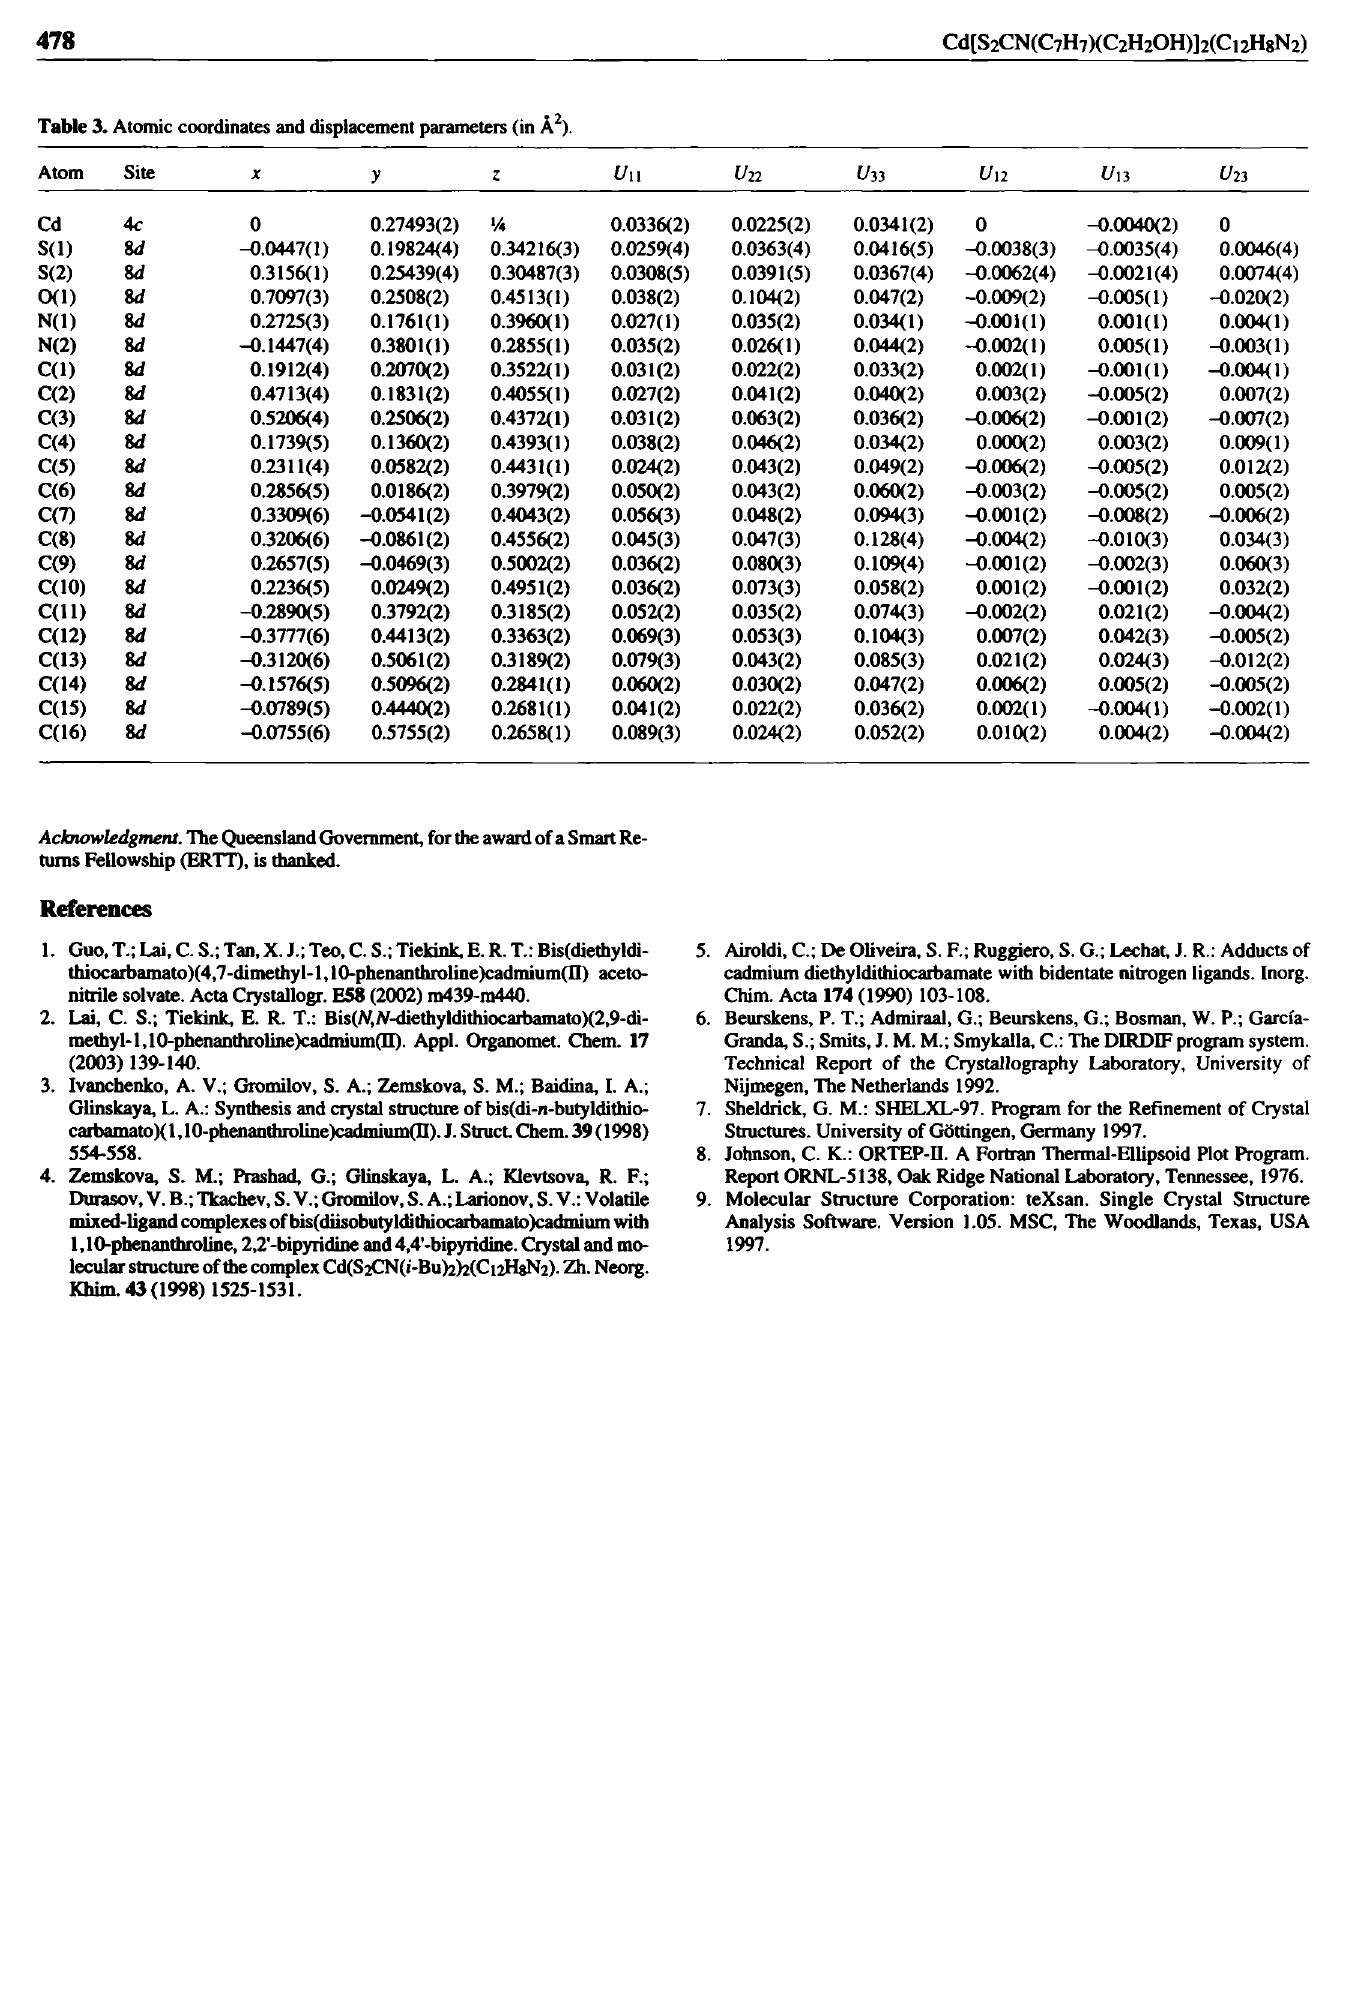
Table 3. Atomic coordinates and displacement parameters (in A 2